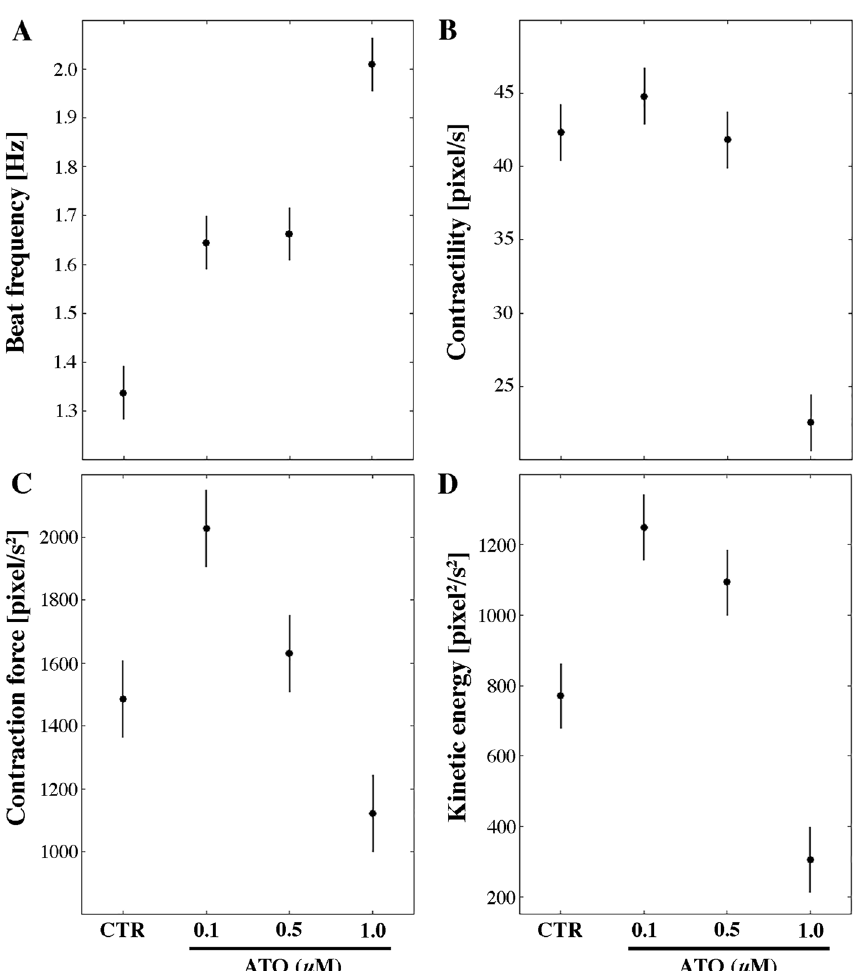
Figure 1. Contractile properties of beating areas within the EBs of control (CTR) and 0.1, 0.5 or 1.0 μM ATO exposed samples for 72 h. In A, beat frequency [Hz]; in B, contractility [pixel/s]; in C, contraction force [pixel/ s 2 ]; in D, kinetic energy [pixel 2 /s 2 ]. The vertical bars represent 95% confidence intervals for the difference between averages according to the "Least Significant Difference" statistical